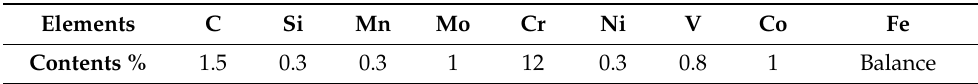
Table 1. Elemental composition of D2 steel